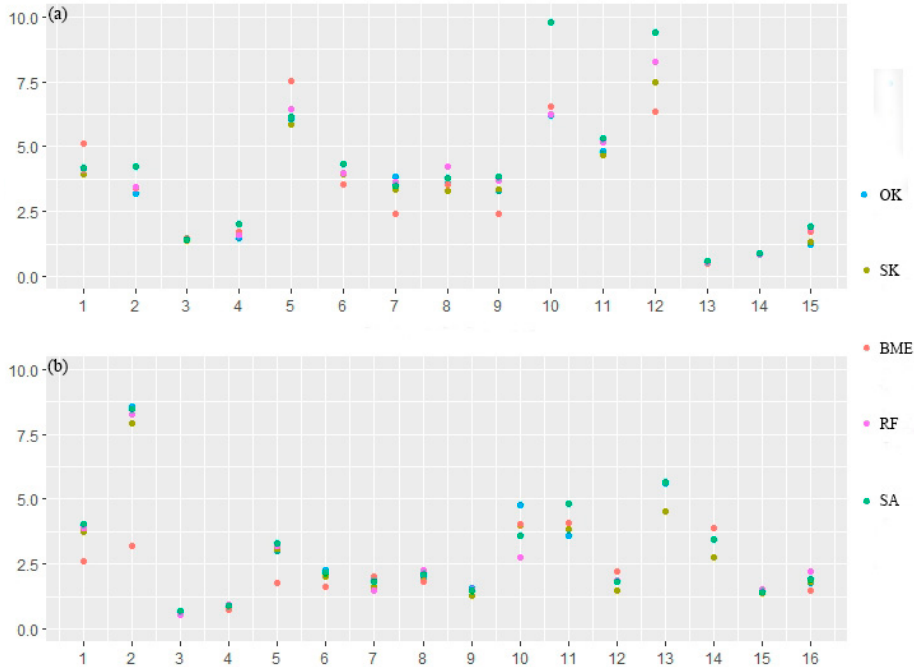
Figure 3. Cross-validation results for each plot: ( a ) 25 km 2 snow plots (Plots Nos. 1–12 are from northern Xinjiang, and Nos.13- 15 are from the northeast), and ( b ) 500 m 2 snow plots (Plots Nos. 1–10 are from northern Xinjiang, Nos. 11–14 are from the Qinghai Tibet Plateau, and Nos. 15–16 are from the northeast).